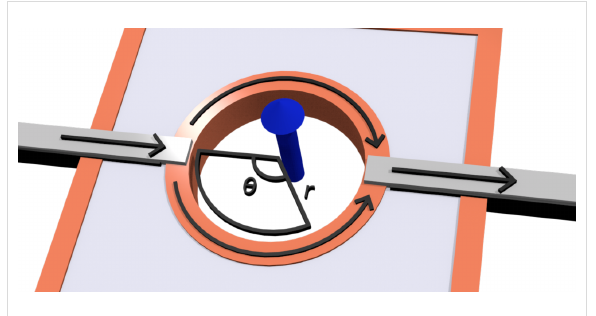
Figure 1: A hole drilled in a 2D TI creates two edge channels (orange). Leads (grey) are attached on each side of the hole, and a bias voltage is applied across the circuit. The transport properties of the device can be altered by threading a magnetic flux (blue arrow) through the hole, as well as by choosing either ferromagnetic or normal leads. The circu- lar shape is not essential, but is used to simplify calculations.